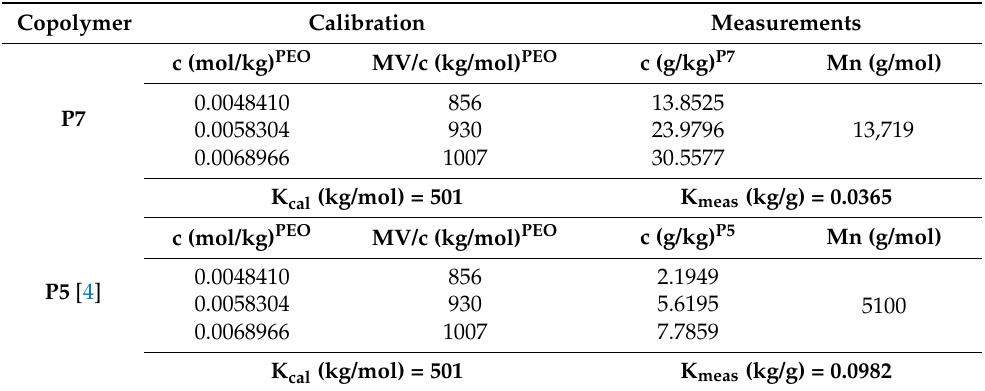
Table 2. Data of calibration, results of measurements and estimation of Mn of P7 according to Equation (2). Data of calibration, results of measurements, and estimation of Mn of the copolymer P5, previously reported, are included for comparison purposes